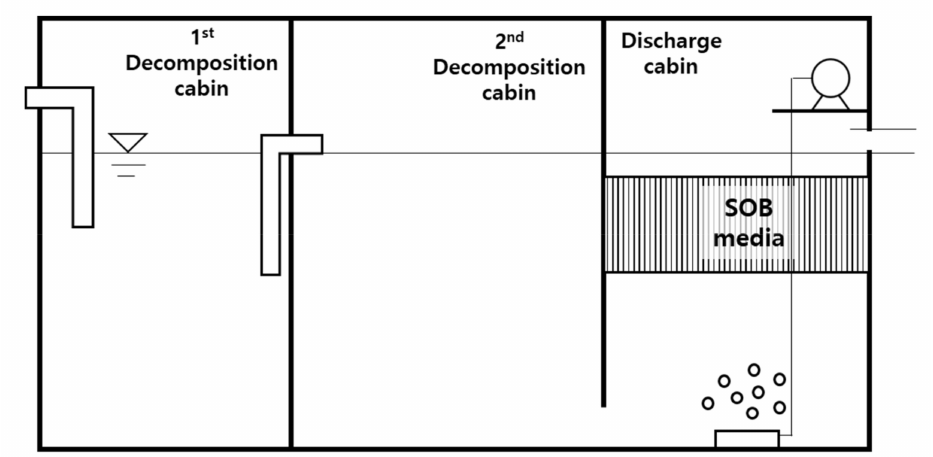
Figure 2. Sulfur-oxidizing bacteria (SOB) media applied in a septic tank for treating black water